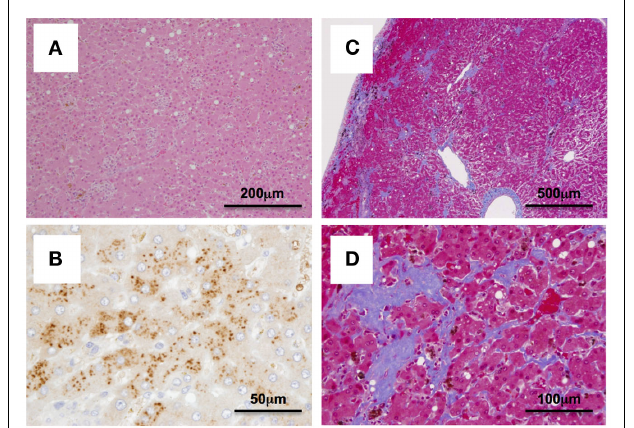
FIGURE 3 | Histopathological and immunohistochemical analyses of the liver from Cj05-004 at week 229 p.i. HE staining (A), immunohistochemical staining for the core protein of GBV-B (B), and Masson’s trichrome staining (C,D) are shown.